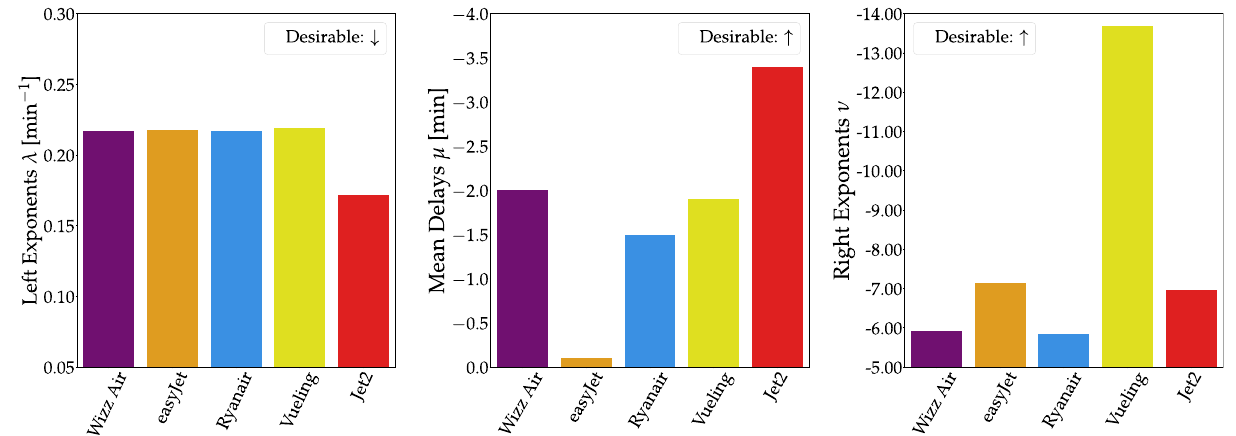
Figure 5. Delay indices for low-cost airlines not covering long-distance flights. Wizz Air, easyjet, Ryanair and Vueling share the largest (cid:31) index (early arrivals). Jet2 has the lowest mean delay µ and Vueling is characterized by the lowest ν index (late arrivals).